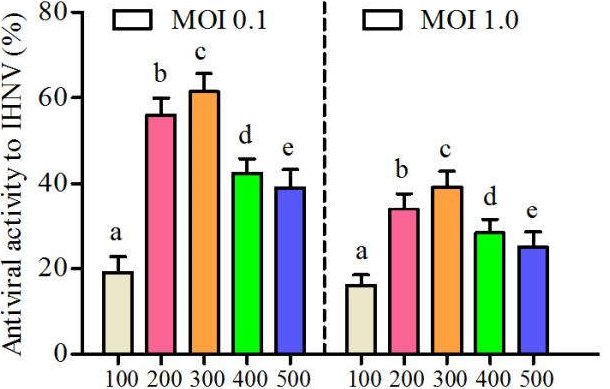
Figure 1. The antiviral activity of CSP to IHNV with a MOI of 0.1 and 1.0, respectively (different letters indicate statistical significance, p < 0.05).